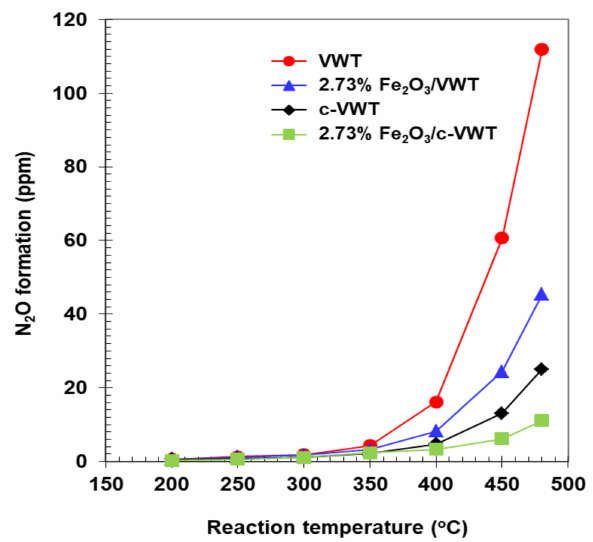
Figure 4. Formation of N 2 O in the reduction of NO by NH 3 over unpromoted and Fe 2 O 3 -promoted V 2 O 5 /TiO 2 -based